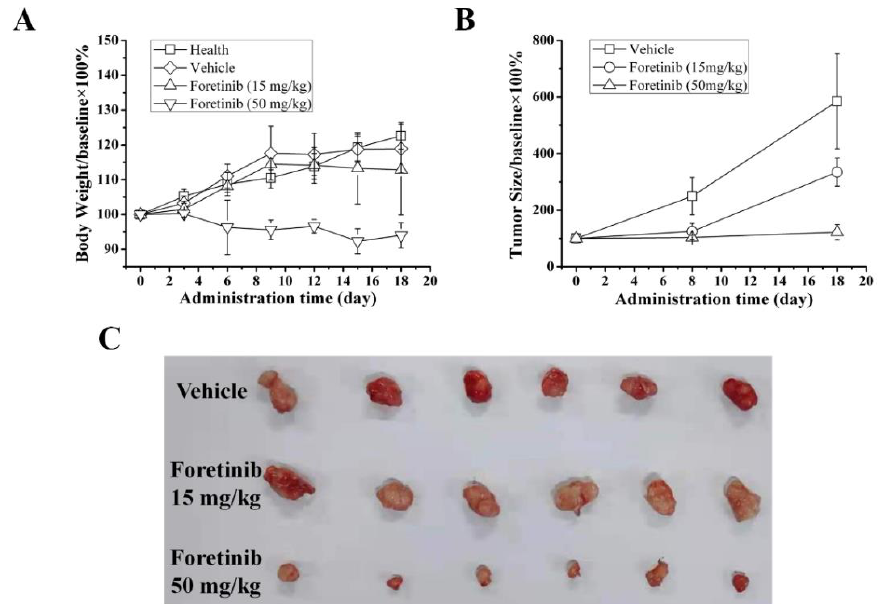
Figure 1. Inhibitory effects of foretinib on MDA-MB-231 xenograft tumors. ( A ) Body weights at different timings in the foretinib-treated groups were similar to those in the vehicle-treated group, indicating that foretinib has low toxicity. ( B ) Foretinib treatment caused a significant inhibition in tumor growth compared with vehicle treatment. ( C ) Photos of the removed tumors of different groups. Each group contains six mice ( n =